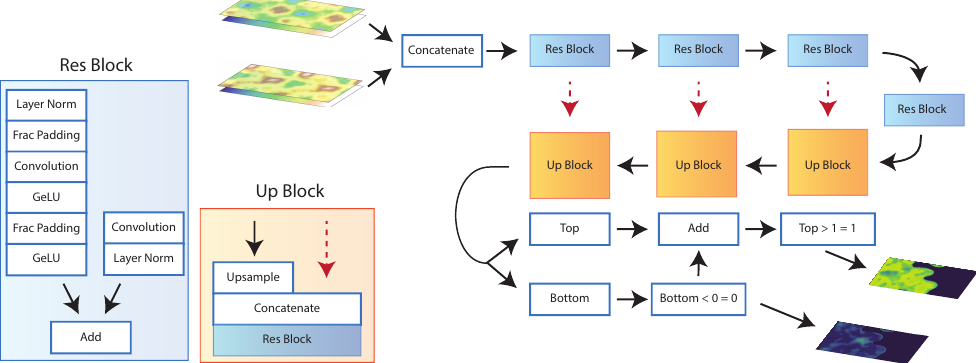
Figure 5. Our network consists on four residual blocks (Res Block) that compress the image size sequentially using strided convolutions and three upsampling blocks (Up Block) with hard physical constraints at the outlet. These constraints make sure that the fluid is always inside the fracture and that the top surface is always above the bottom surface. These allow the model optimize the weights faster and provide physical predictions in unseen